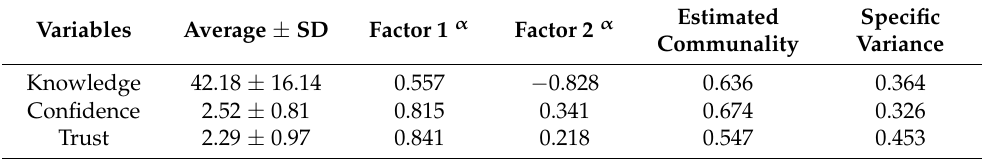
Table 6. Descriptive characteristics and factor loading matrix of variables in factorial analysis (FA).